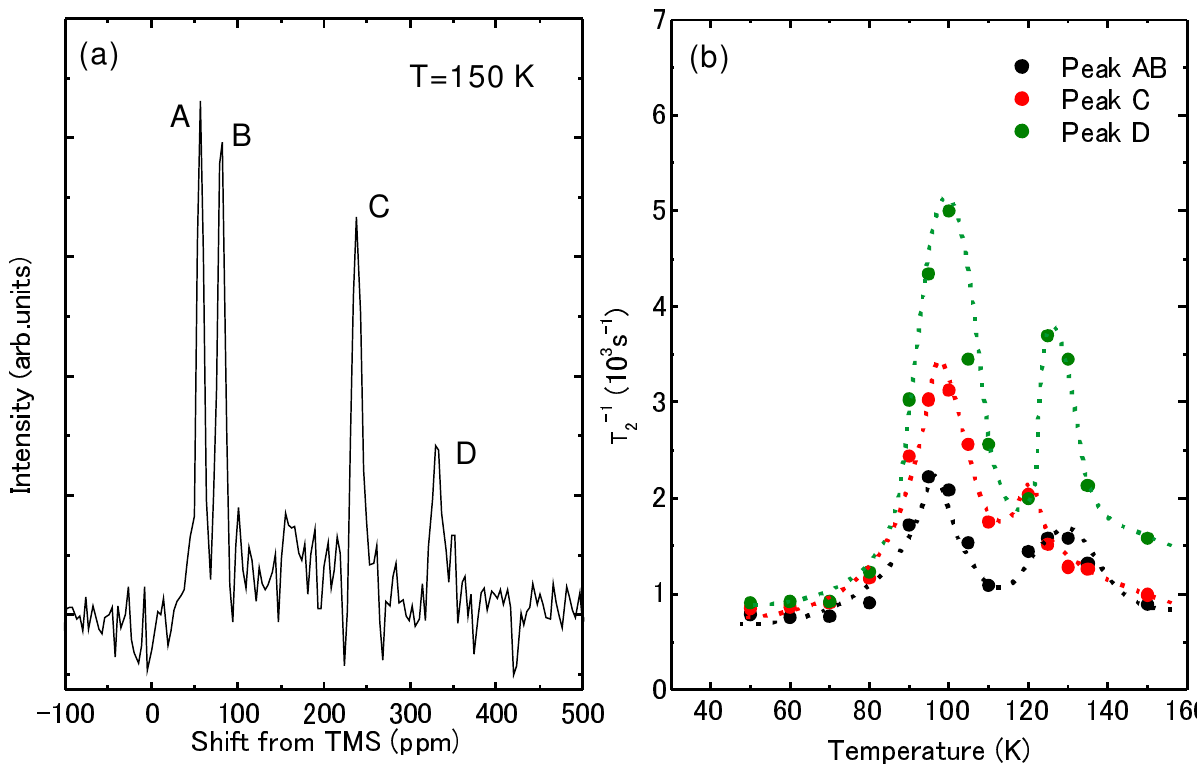
Figure 12. ( a ) 13 C NMR spectra of κ -(BEDT-TTF) dependence of T 2−1